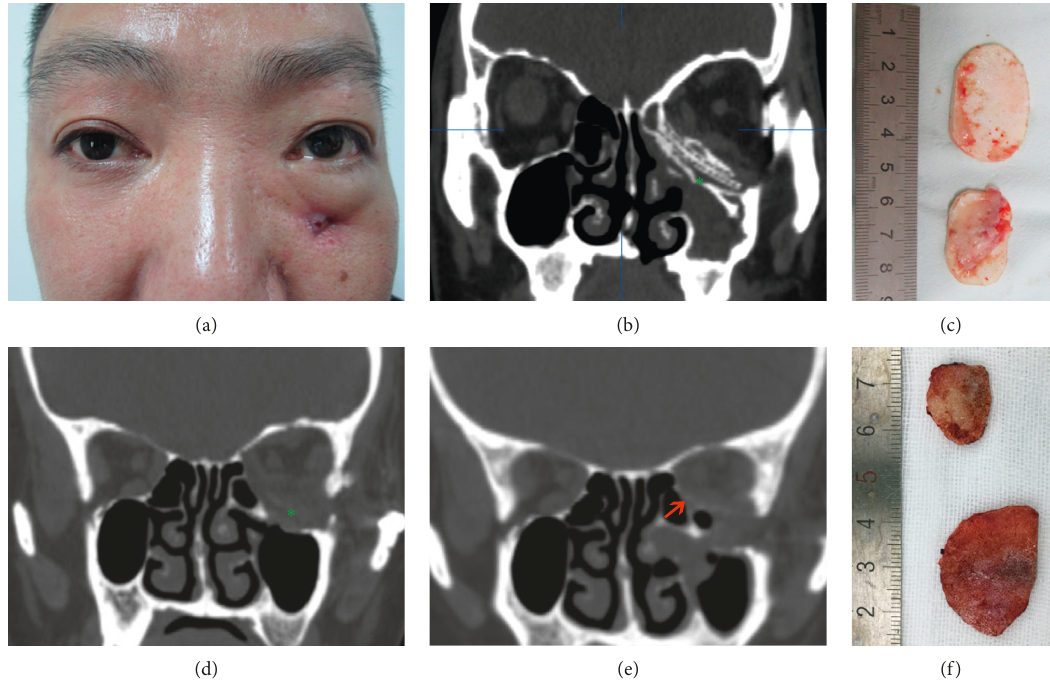
Figure 4: Two cases of implant infections. (a) Patient with infraorbital intermittent swelling and fistula 9years after implantation of hydroxyapatite. (b and d) CTshowing intraorbital abscesses in these two cases (asterisks). (c and f) The explanted implants. (e) Orbital walls were secondarily reconstructed using Rapidsorb in a one-stage procedure with removal of the previous implants (red